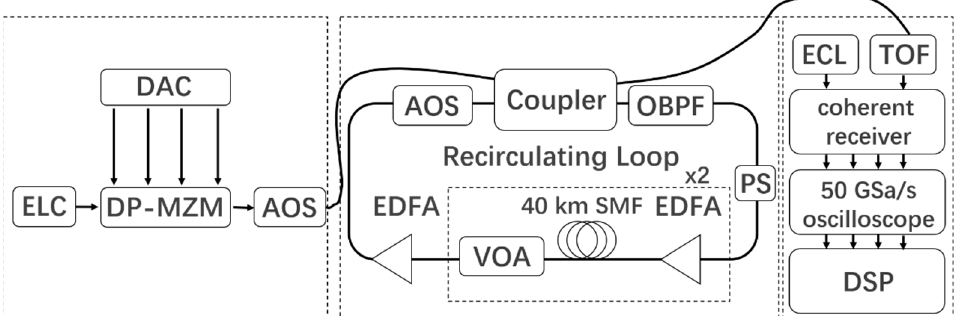
Figure 8. Experiment setup of 28-GBaud PDM-16 QAM transmission. ELC: external cavity laser; DP-MZM: dual-polarization Mach Zehnder modulator; AOS: acousto-optic switch; PS: polarization scrambler; OBPF: optical band-pass filter; VOA: carriable optical attenuator; SMF: standard single- mode fiber; TOF: tunable optical filter.